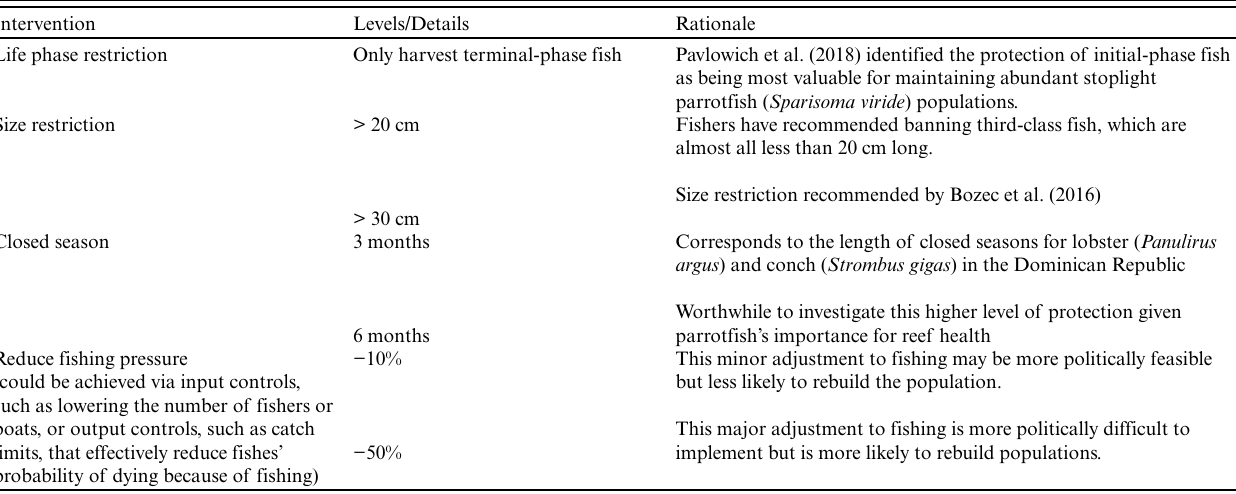
Table 3 . Management options identified and